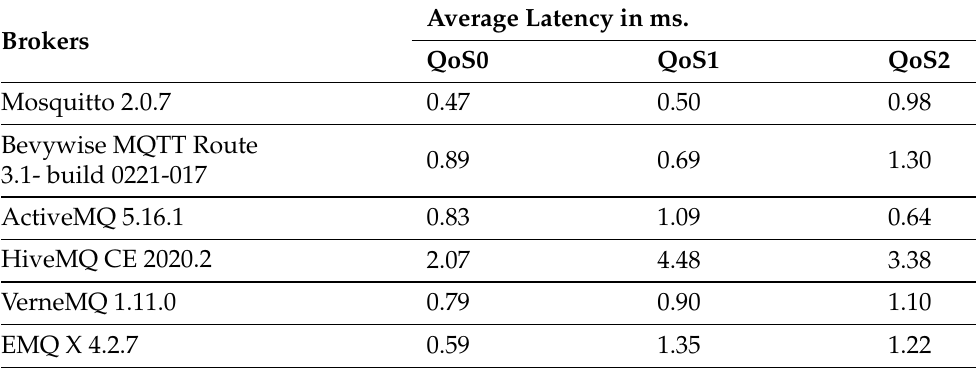
Table 11. Latency comparison of all the brokers in the cloud evaluation